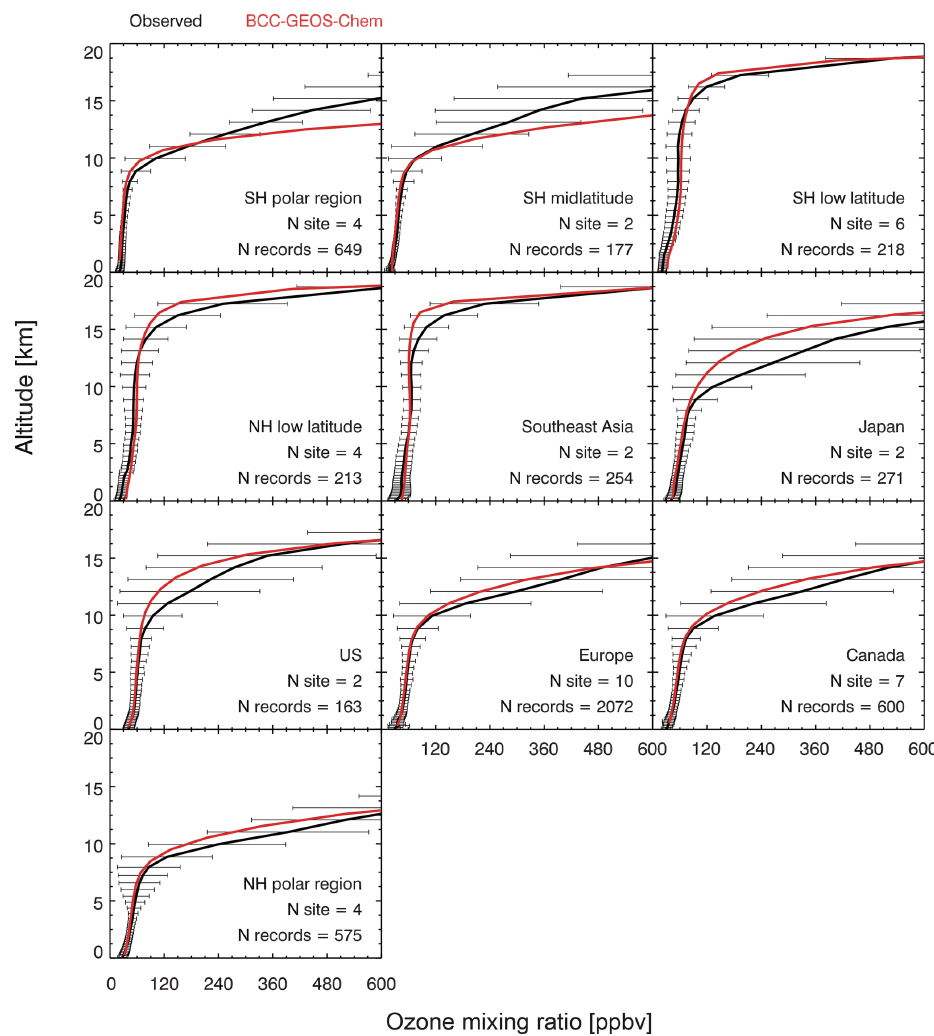
Figure 5. Comparisons of BCC-GEOS-Chem v1.0 simulated annual mean ozone vertical profiles to ozonesonde observations averaged over the 10 regions (Fig. 3) from south to north. Black horizontal bars are the standard deviations of observations. Numbers of available sites and records for each region in 2012–2014 are given